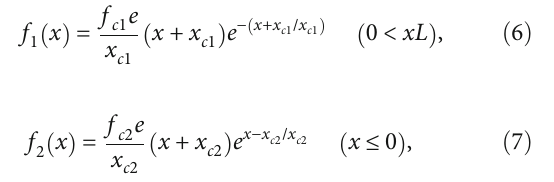
Figure 6: Energy distribution curve of inclined suspended roof